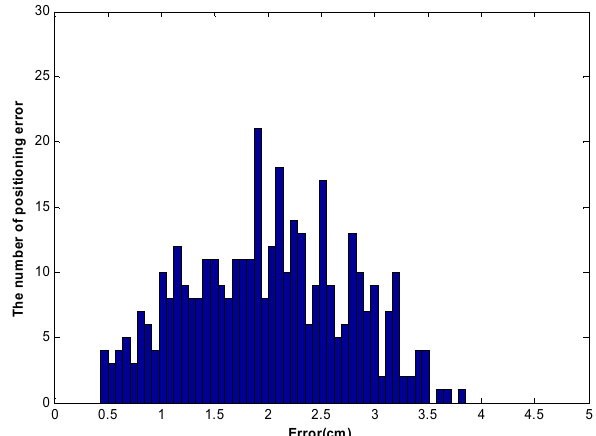
Figure 12. Histogram of the triple-light positioning error in double-light positioning system.